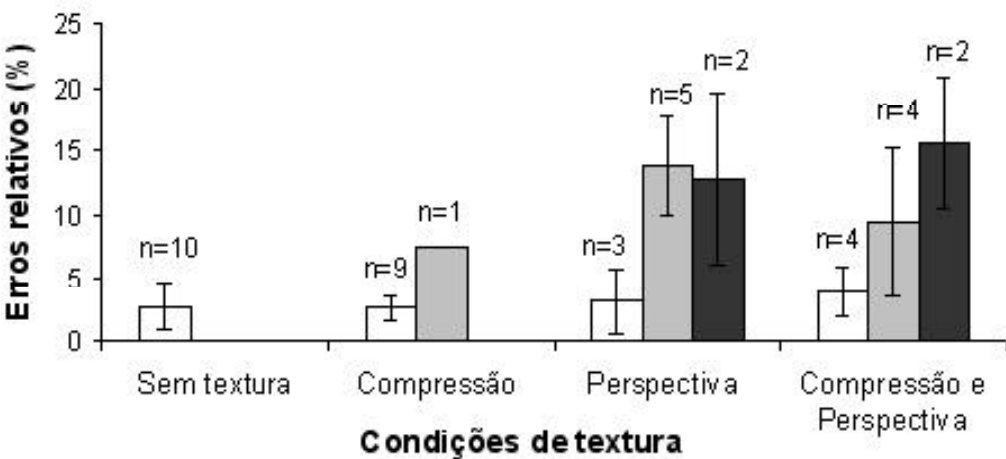
Figura 5. Erros relativos dos quatro grupos experimentais (condições de textura), distribuídos em função da estratégia de julgamento adotada pelos observadores no experimento ( n =número de